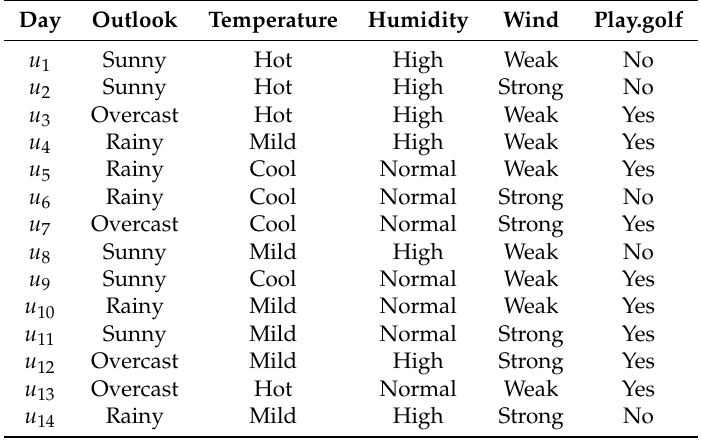
Table 1. Exemplary decision system ( U , A , d ) by J. R. Quinlan